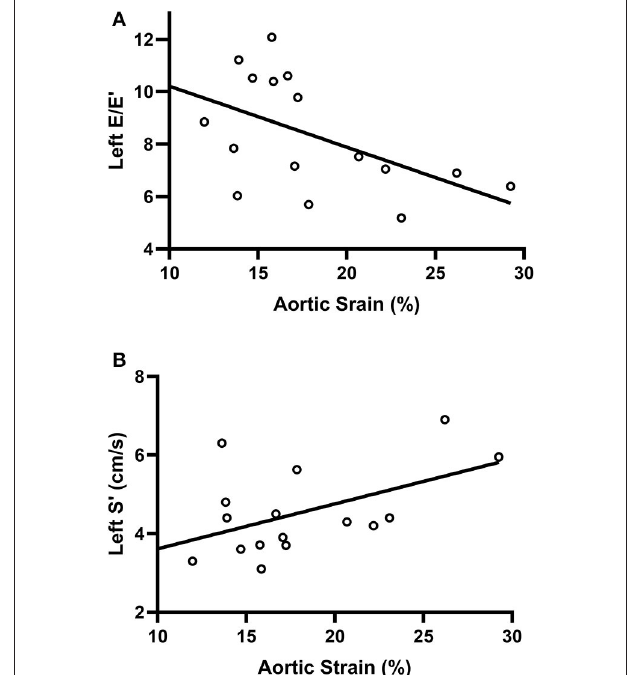
FIGURE 3 | Regression curves demonstrating the association of aortic strain with left E/E’ (A) and S’ (B) in the fetuses with CoA. There was a negative correlation between the strain of the AAo and left E/E’ and a positive correlation between aortic strain and left S’ in the CoA group ( r = − 0.522 and 0.504, respectively, P < 0.05). S’, peak systolic myocardial velocities, E/E’, the early diastolic velocity